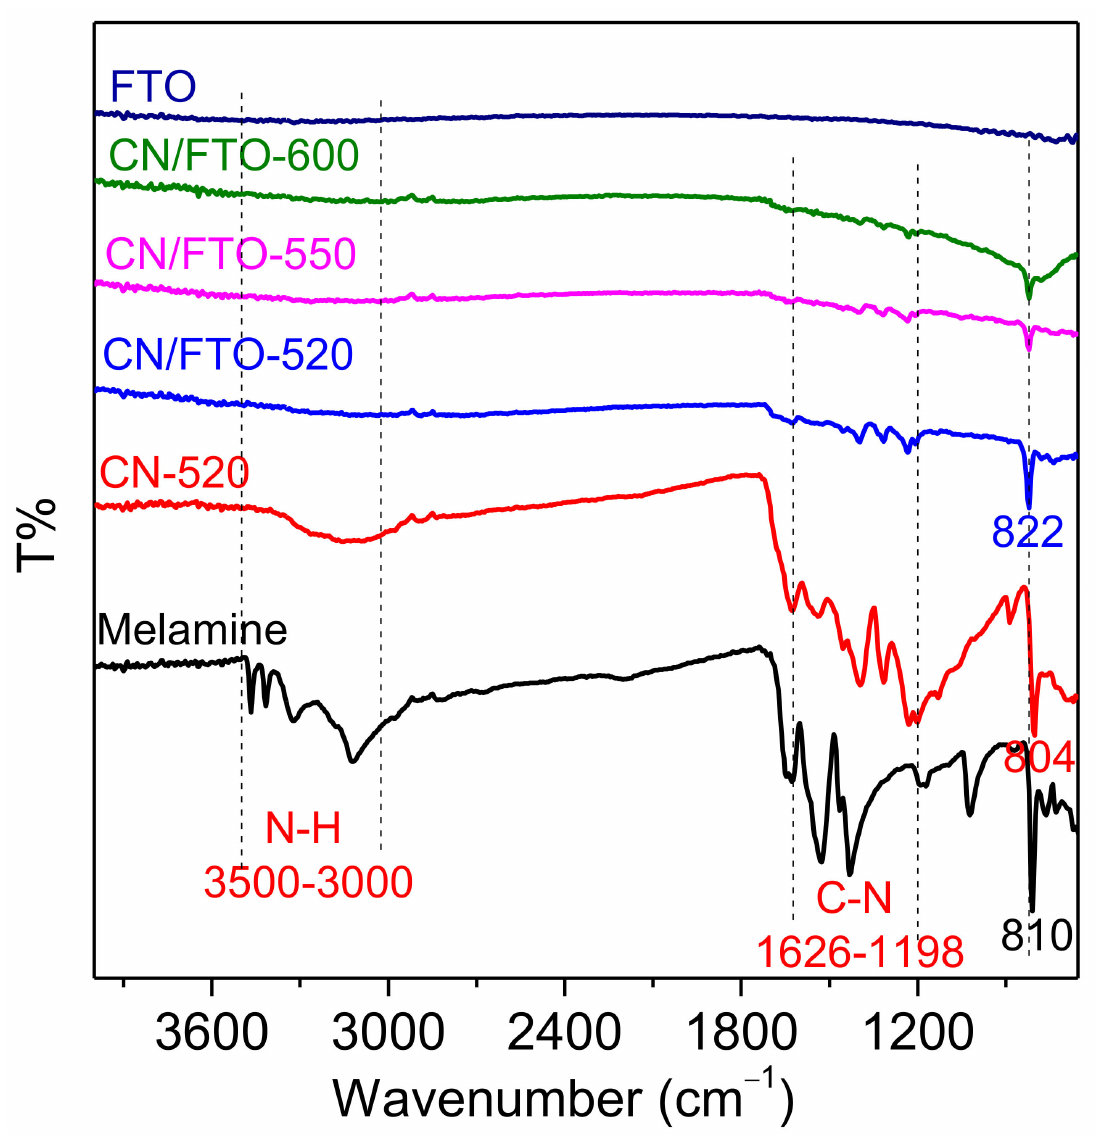
Figure 5. ATR-FTIR spectra of pure melamine and typical g-C 3 N 4 powder (CN-520), FTO substrate, and CN/FTO